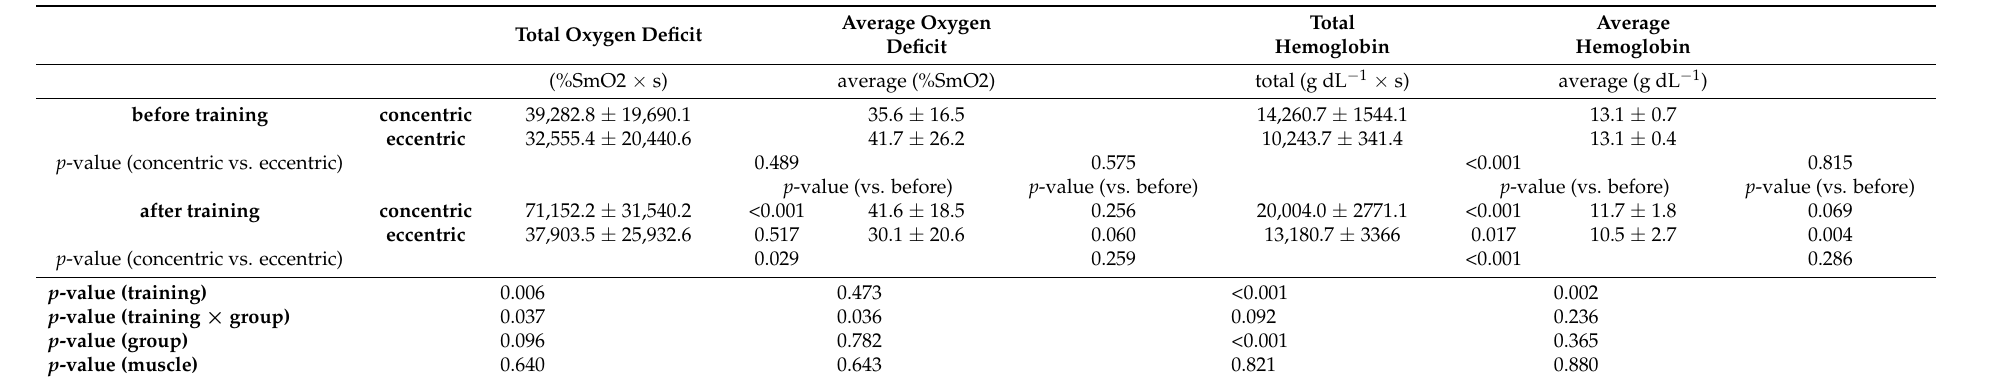
Table 3. Metabolic stress of muscle during interval exercise. Top) Mean ± SD, and post-hoc p -values, bottom) and p -values of the main effects of interval ‘training’, the contraction ‘group’, and muscle, on the average and total oxygen deficit and hemoglobin concentration accruing in m. vastus lateralis and m. gastrocnemius combined during interval exercise before and